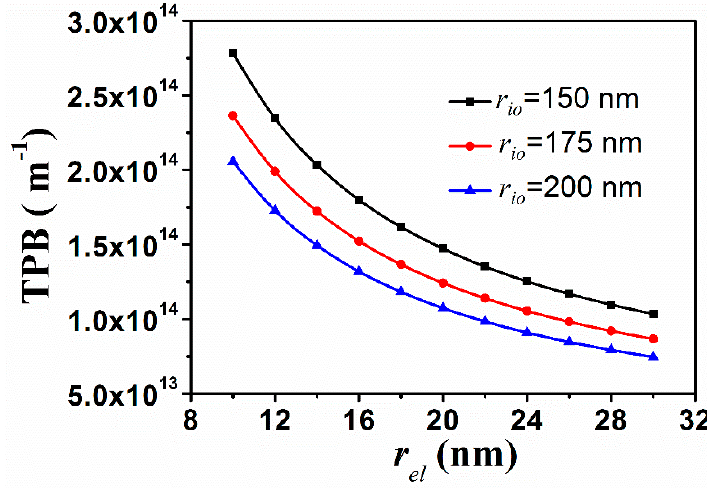
r and r . Figure 8. The dependence of TPB length on r el and r io el io